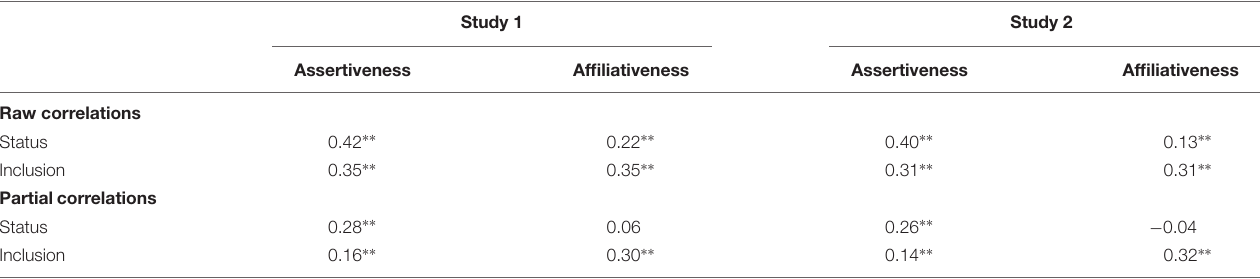
TABLE 4 | Raw and partial correlation between social relations and interpersonal